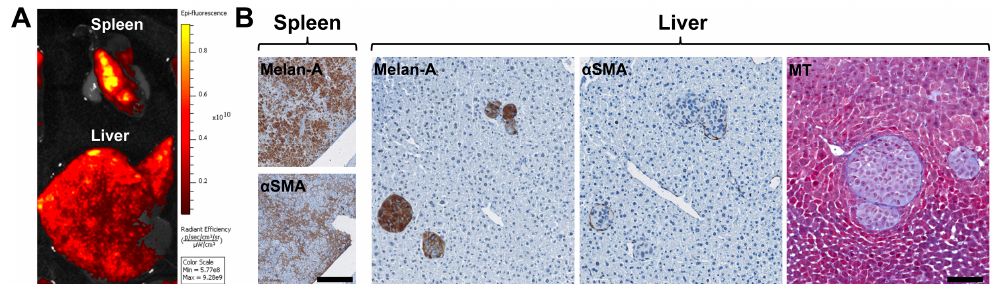
Figure 2. Establishment of a mouse xenograft model of metastatic UM to assess the recruitment of HSteCs. ( A ) Ex vivo fluorescence imaging of the liver and spleen of a triple-immunodeficient mouse bearing UM metastases generated with the TJU-UM001 cell line co-inoculated with human HSteCs. The color scale indicates the intensity of the fluorescence recorded 6 weeks post-inoculation, where the yellow signal corresponds to the highest concentration of UM cells. ( B ) Immunohistological analyses of UM-derived liver metastases using the Melan-A antibody to identify melanoma malignant lesions, and the α SMA antibody to label activated stellate cells; the positive signal appears in brown. The Masson’s Trichrome (MT) stain reveals the presence of collagen in blue. Scale bars, 100 µm.